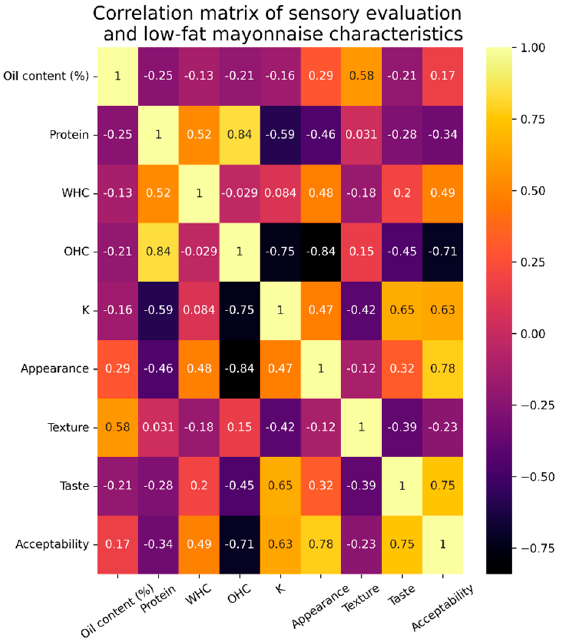
Figure 6. Correlation matrix of low-fat mayonnaise characteristics and sensory attributes.